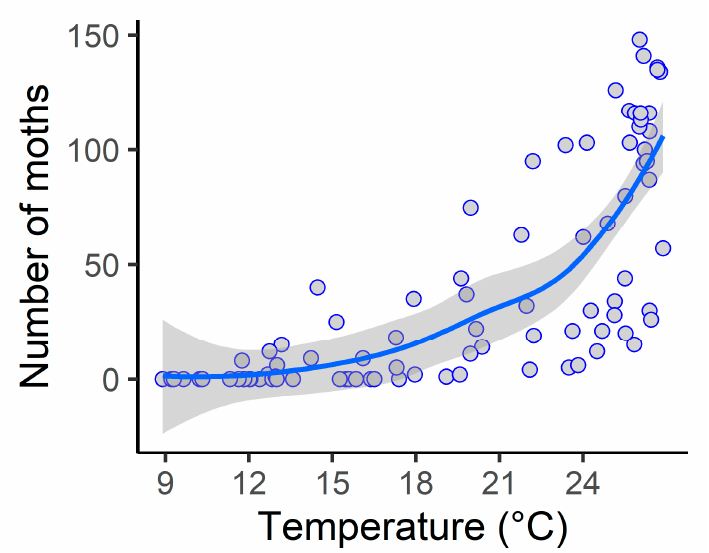
Figure 3. Expected counts of the LCSB male moths as a function of temperature from the previous 45 days (average) in Jay, Santa Rosa County, Florida. The blue line indicates the fitted model (GAMM with quasi-Poisson distribution) and the confidence intervals (grey color). Each blue circle represents the number of insects collected every 15 days in a delta trap for four years. ( n = 85).